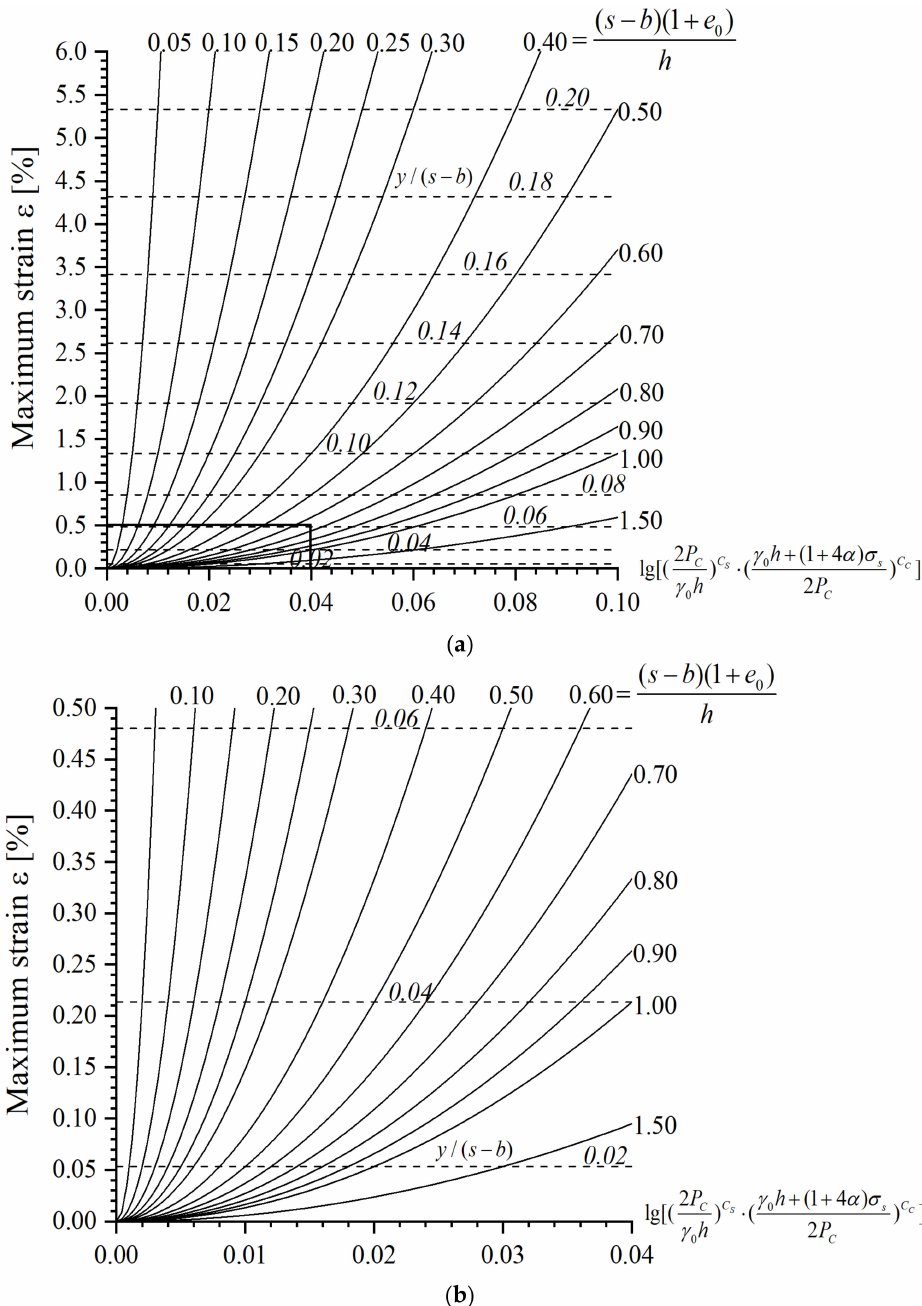
Figure 8. Design charts for a GRPE with over-consolidated soil ( ∆ p > ( p c − p 1 ) ); ( a ) Full-scale chart; ( b ) Enlarged